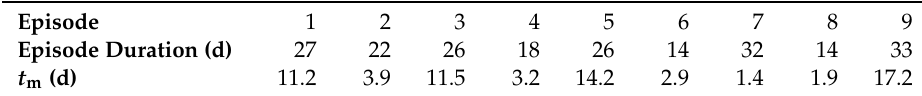
Figure 4. Cumulative travel time distributions of stormflow ( a ), deep percolation ( b ), and transpiration ( c ), as well as aggregate distributions combing all discharge processes ( d ) for the selected rainfall–runoff episodes. Median travel times t m for stormflow correspond to the value of cumulative travel time distribution equal to 0.5. Table 2. Estimated median travel times t m of stormflow determined for the selected rainfall–runo ff